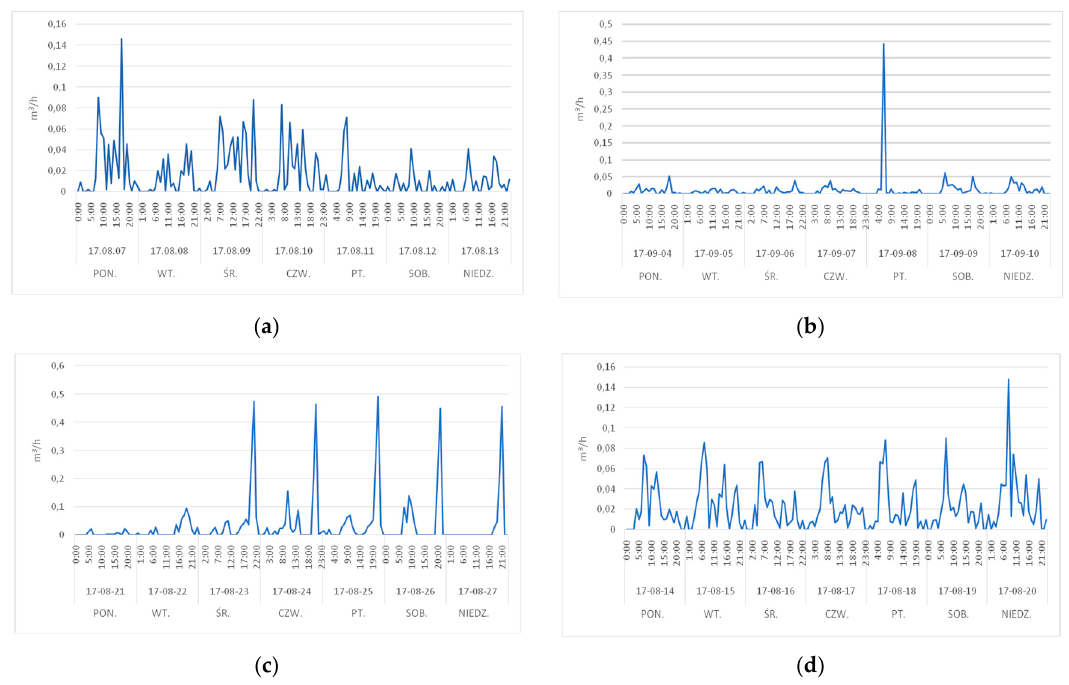
Figure 1. Examples of hourly water consumption in weekly periods in selected single-family houses: ( a ) Building No. 1, ( b ) building No. 6, ( c ) building No. 7 and ( d ) building No. 9.